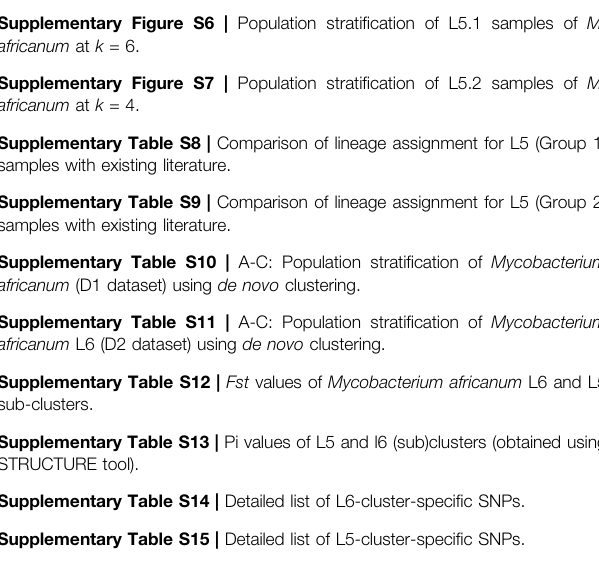
Supplementary Table S8 | Comparison of lineage assignment for L5 (Group 1) samples with existing literature. Supplementary Table S9 | Comparison of lineage assignment for L5 (Group 2) samples with existing literature.